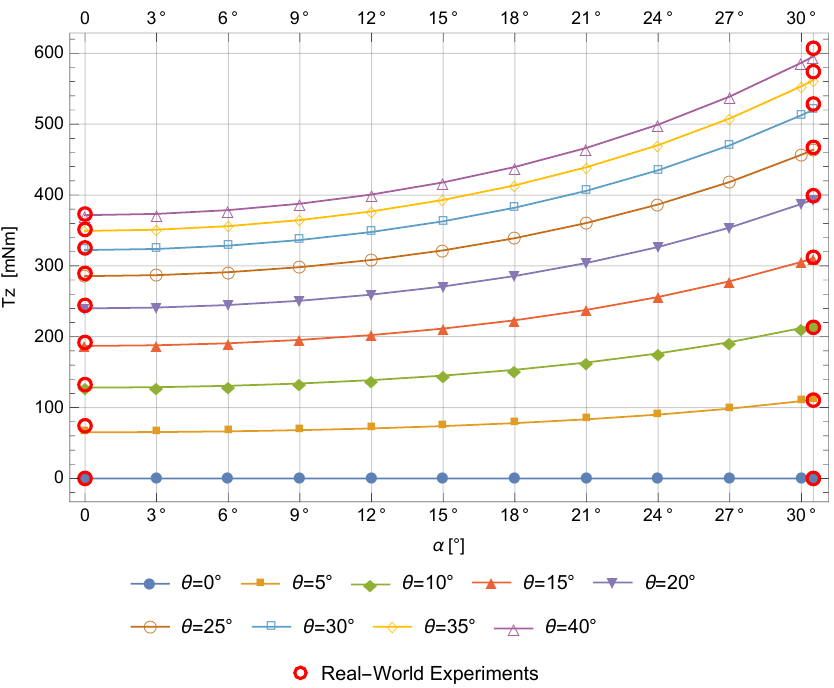
Figure 10. α axis view of simulation and experimental results for T z ( α , θ ) .